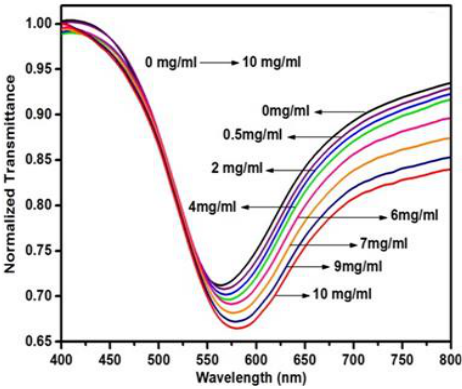
Figure 12. SPR curve recorded for the characterization of vitamin B 3 sensor using MIP for the concentration range of 0–10 mg/mL. Reprinted with permission from [159]. Copyright 2013